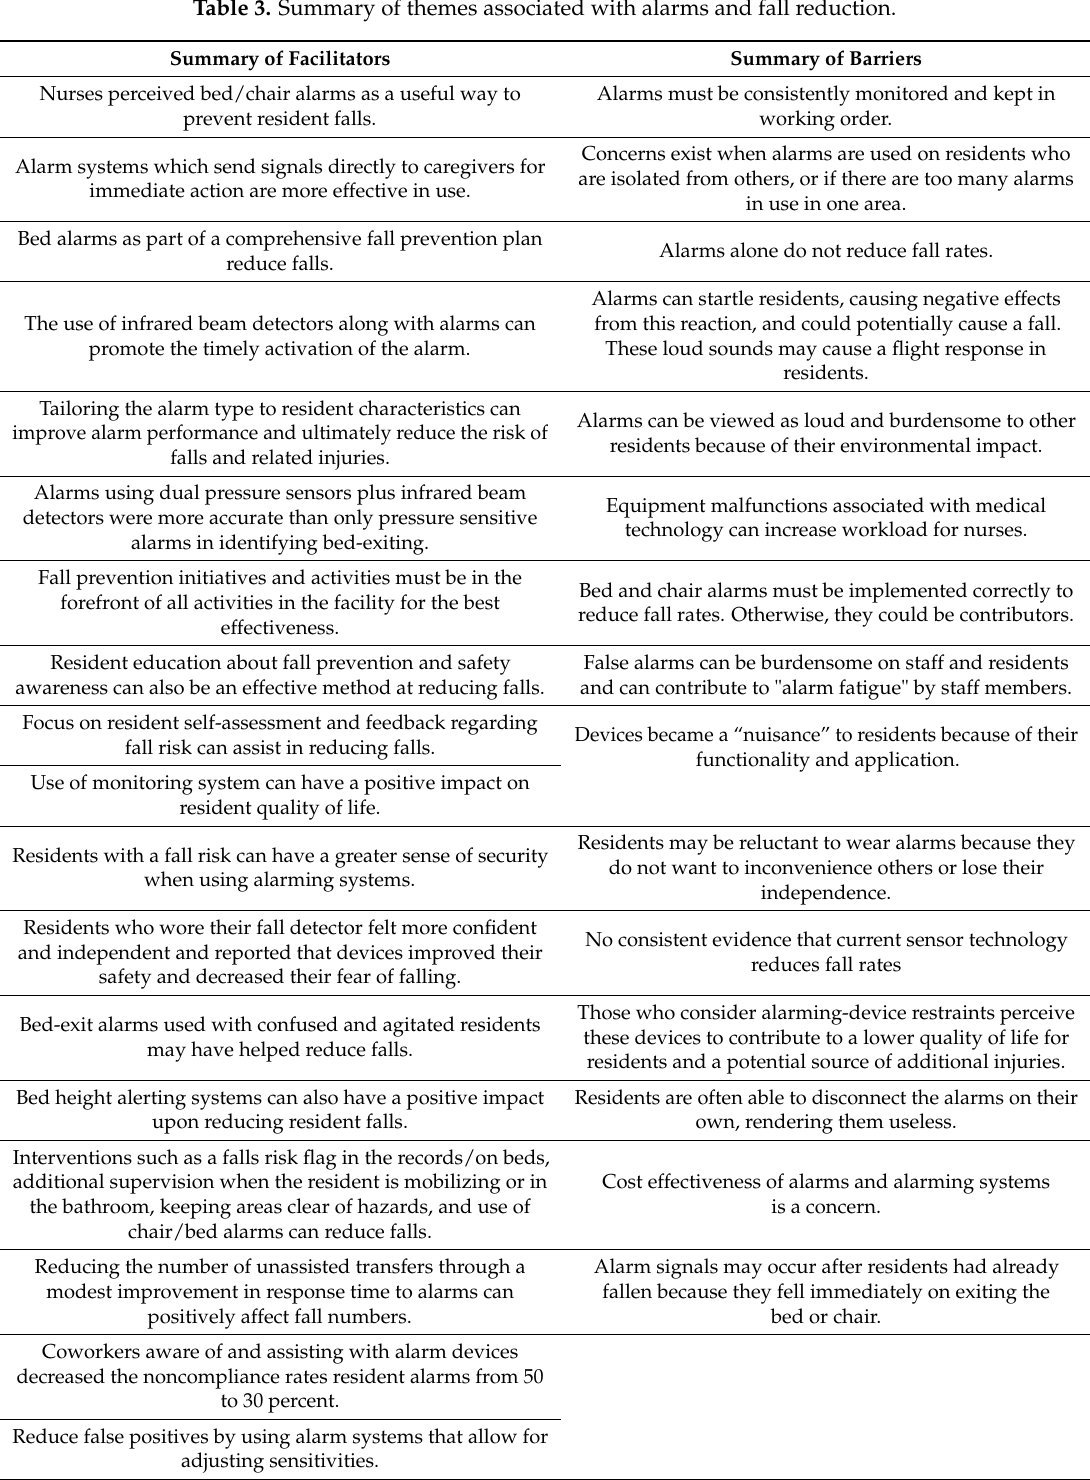
Table 3. Summary of themes associated with alarms and fall